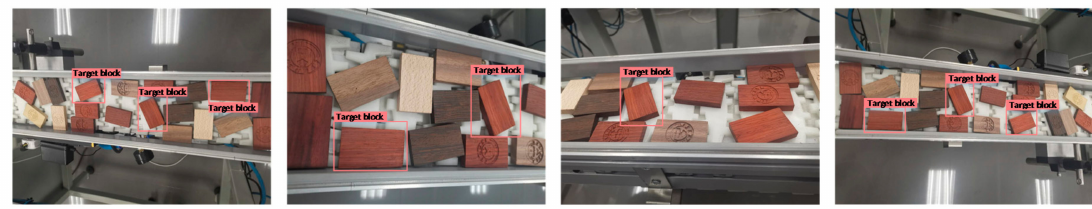
Figure 11. Detection result of the multitarget